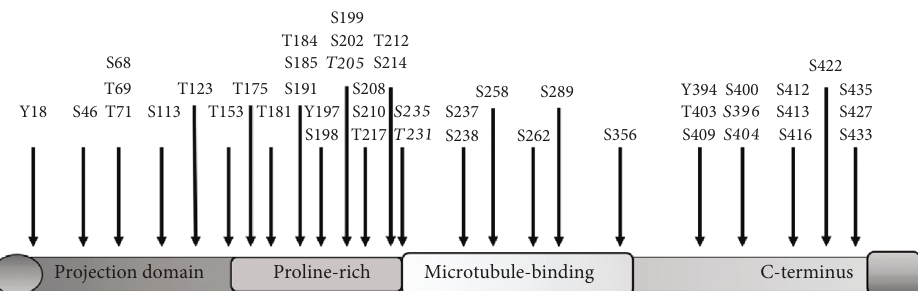
Figure 1: Tau sequence can be subdivided into two active domains that are phosphorylated throughout. Tau protein contains an assembly domain (carboxy-terminus section that contains the microtubule-binding and fl anking regions; right). It also contains a middle region (comprising the proline-rich domain that contains multiple Thr-Pro of Ser-Pro motifs). Finally, Tau contains the amino-terminal section (left).